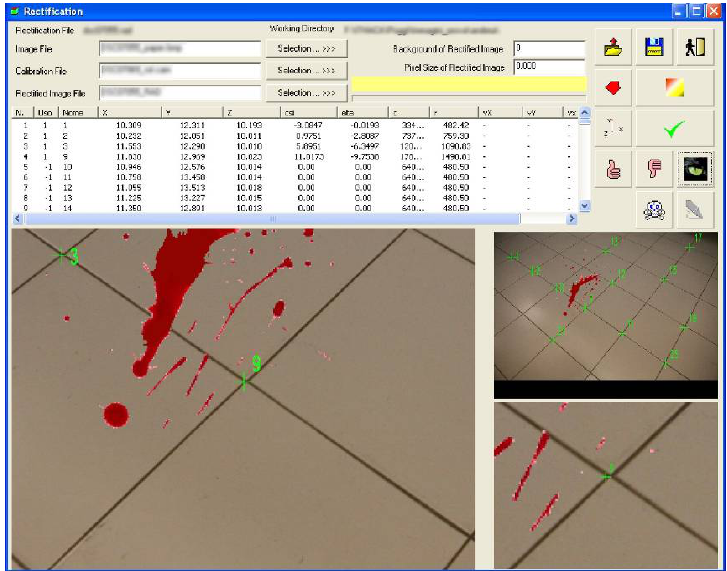
Figure 6. The CRS rectification module: GCP